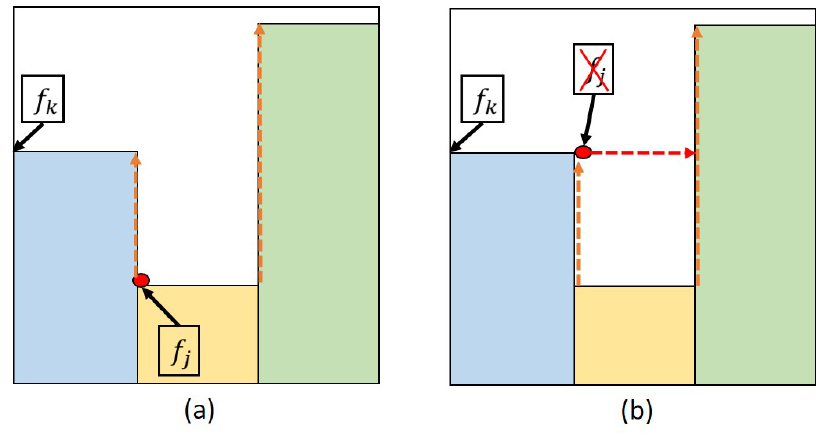
Figure 5. ( a ) Rise flag first case. ( b ) The flag fix.